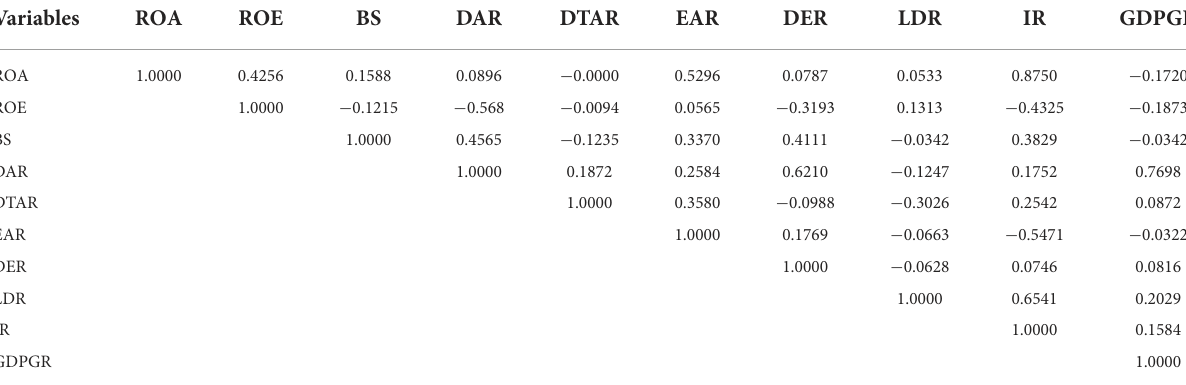
TABLE 8 Correlation coefficients based on 300 observations.